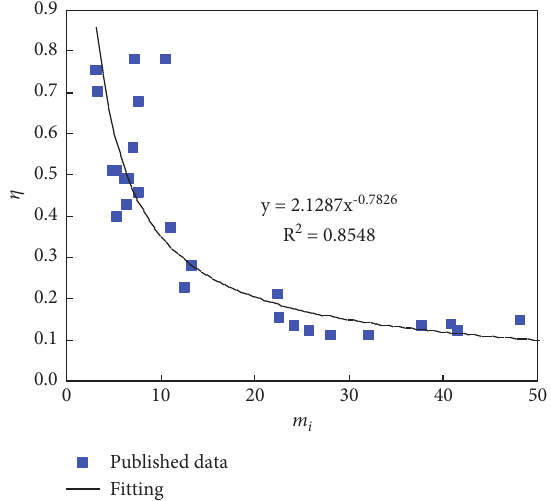
Figure 5: Correlation of the parameters η and mi of the H–B model.